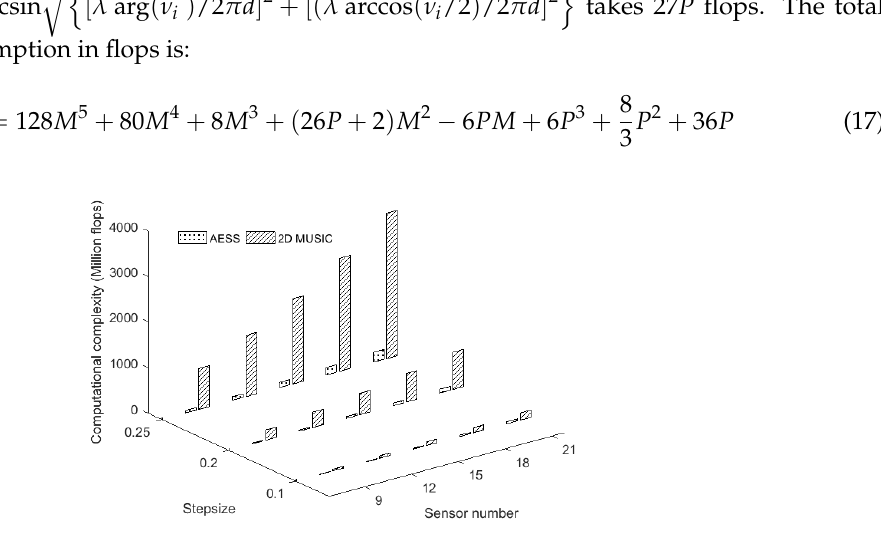
Figure 4. Computational complexity versus the sensor number and stepsize.